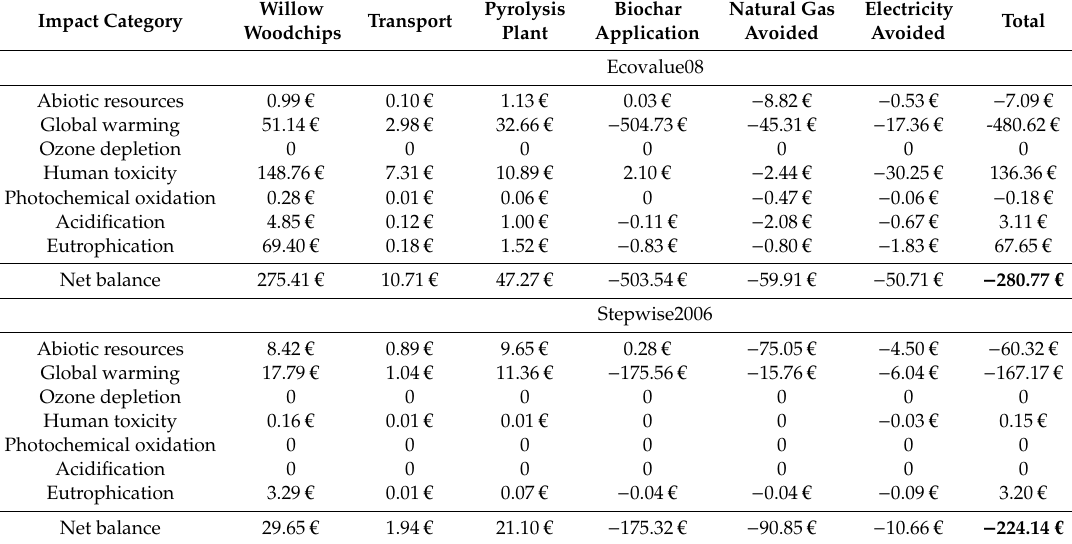
Table A2. Environmental valuation per 1 ton biochar produced from